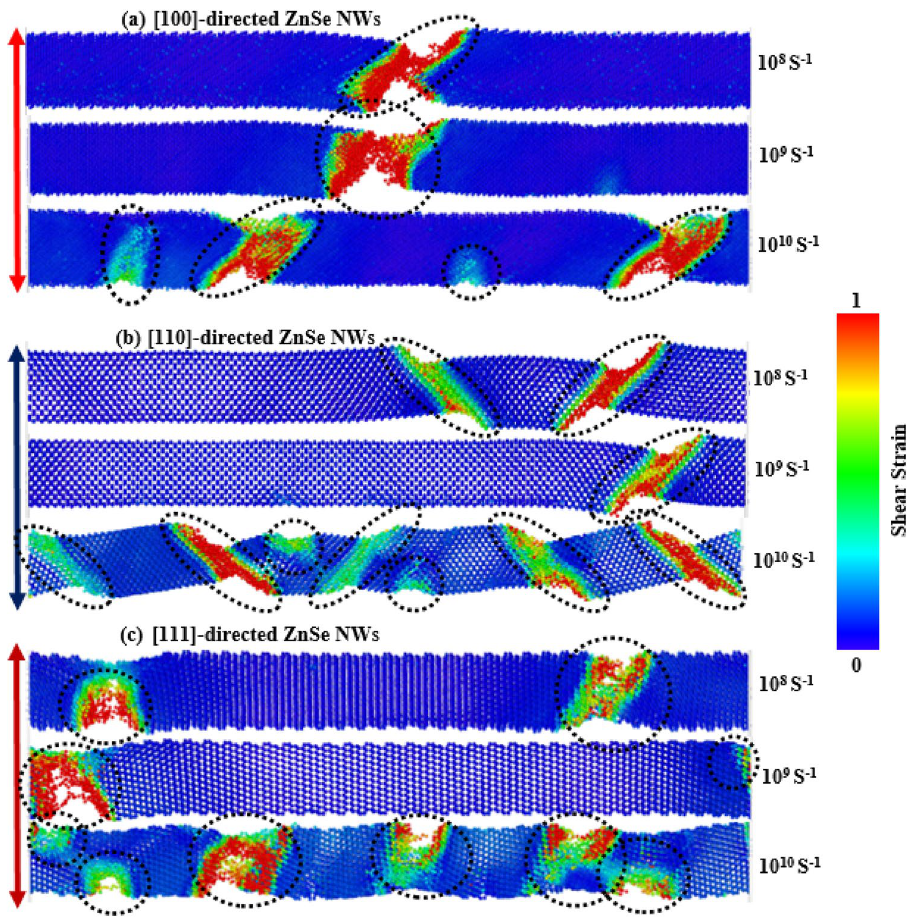
Figure 12. Variation in the deformation mechanisms of zinc-blende ZnSe NWs for three different tensile strain rates along the ( a ) [100], ( b ) [110], and ( c )